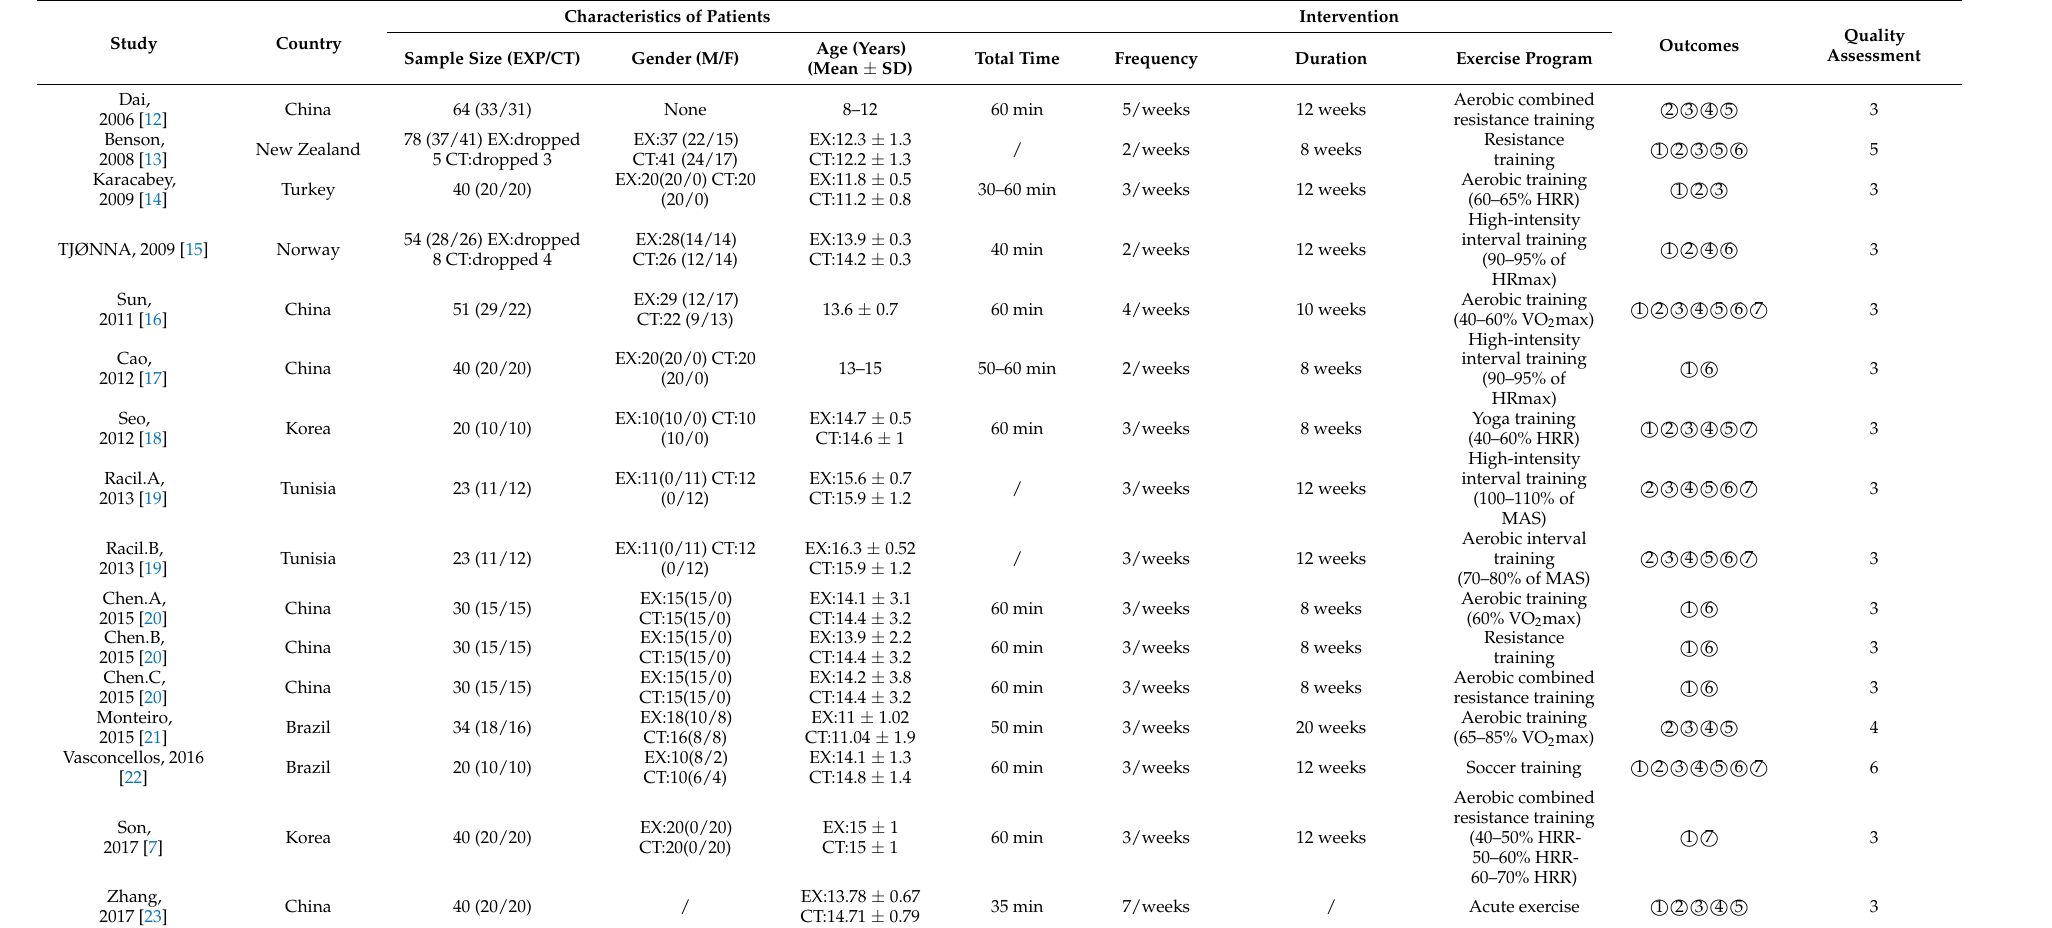
Table 2. Characteristics of the studies included in the